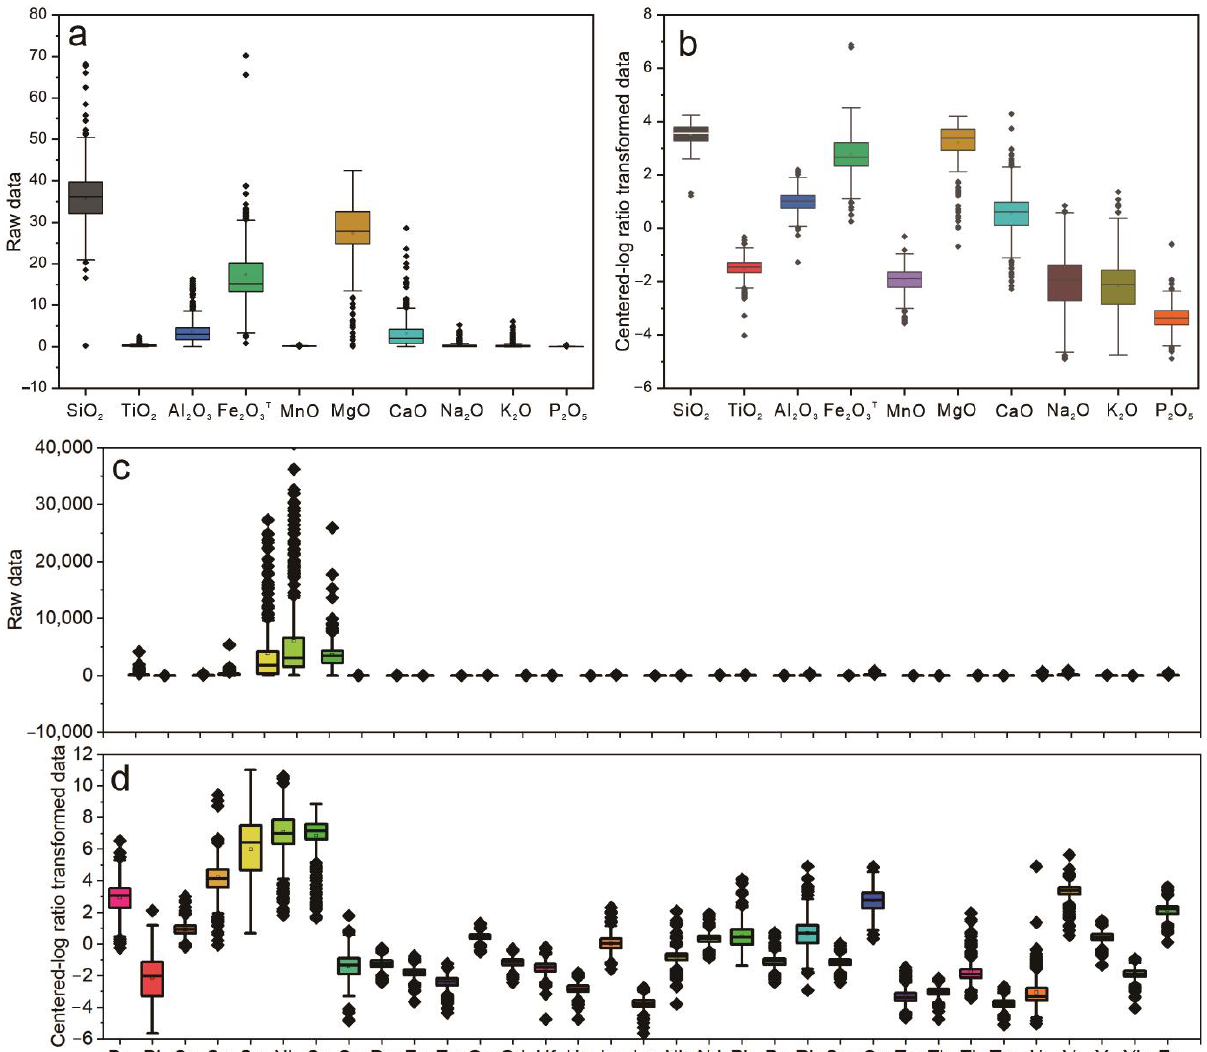
Figure 6. Box plot of raw ( a , c ) and centered-log ratios transformed ( b , d ) dataset. Data from this study, unpublished data and [17,23,24,29,31,36,38,44,46,65].